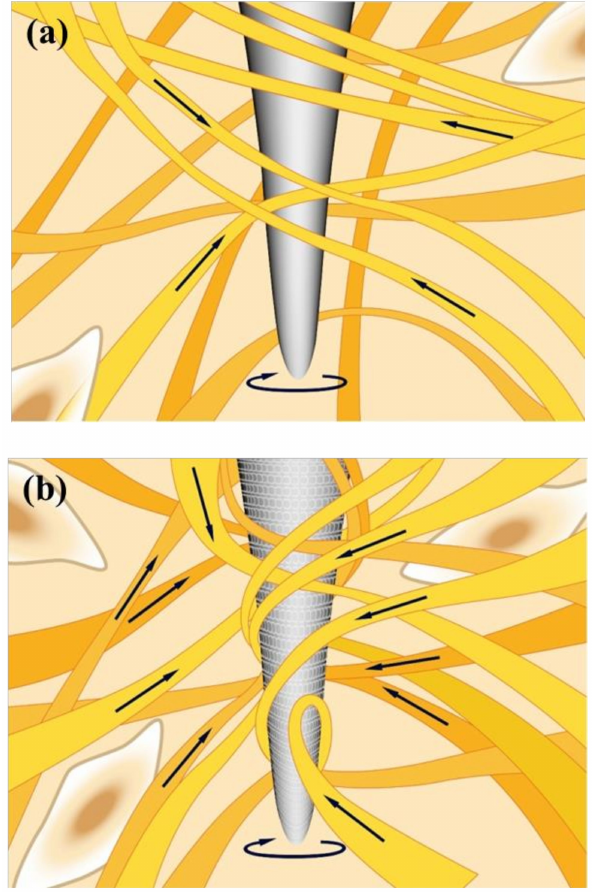
Figure 5. The nano-modified acupuncture needle has the ability to increase tissue winding e ff ect due to the increased surface area on the needle shaft: ( a ) tissue winding e ff ect of the U-SS needle and ( b ) tissue winding e ff ect of the Nano-SS